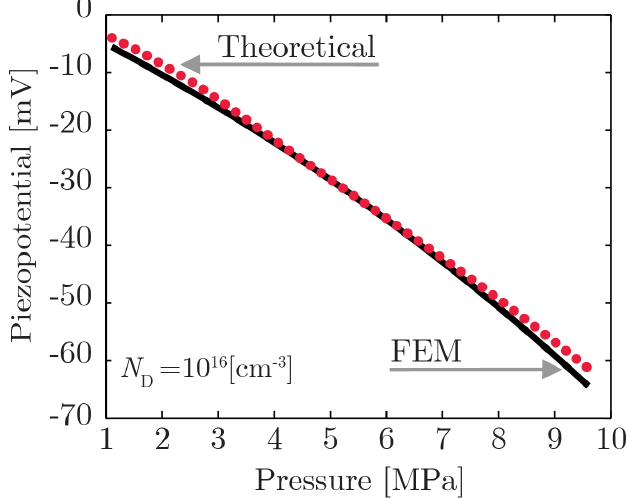
Figure 9. Comparison of the theoretical prediction of the piezopotential at the tip of the NW versus the numerical results obtained by means of the FEM